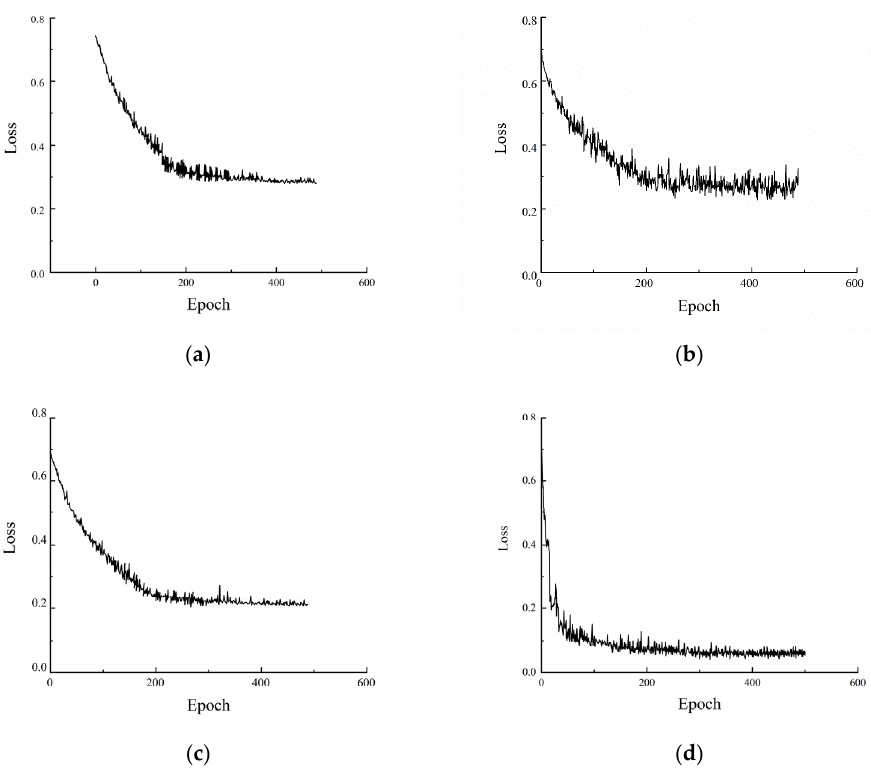
Figure 8. Model e ff ect comparison. ( a ) Unet. ( b ) VGG. ( c ) Res2net50. ( d ) Our